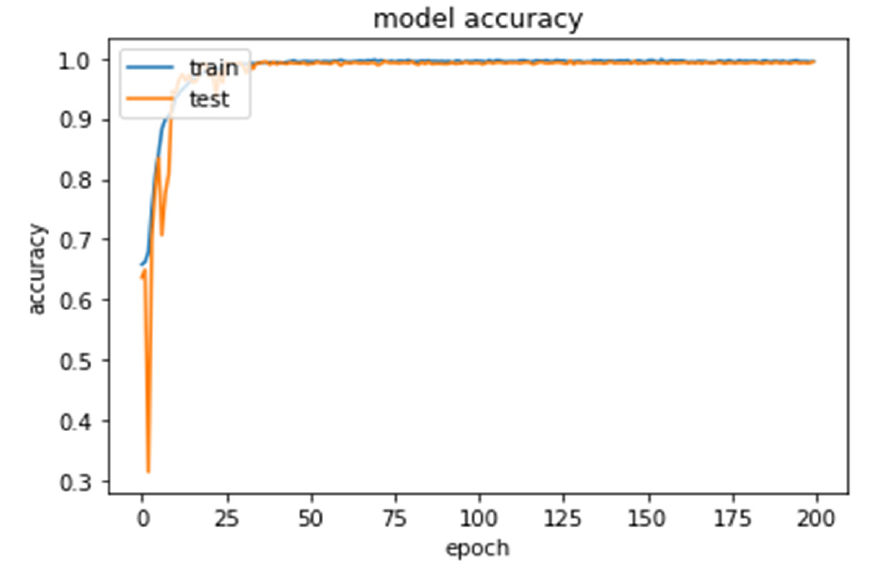
Figure 6. Model’s training and test accuracy over epochs with RMSprop and ReLU.